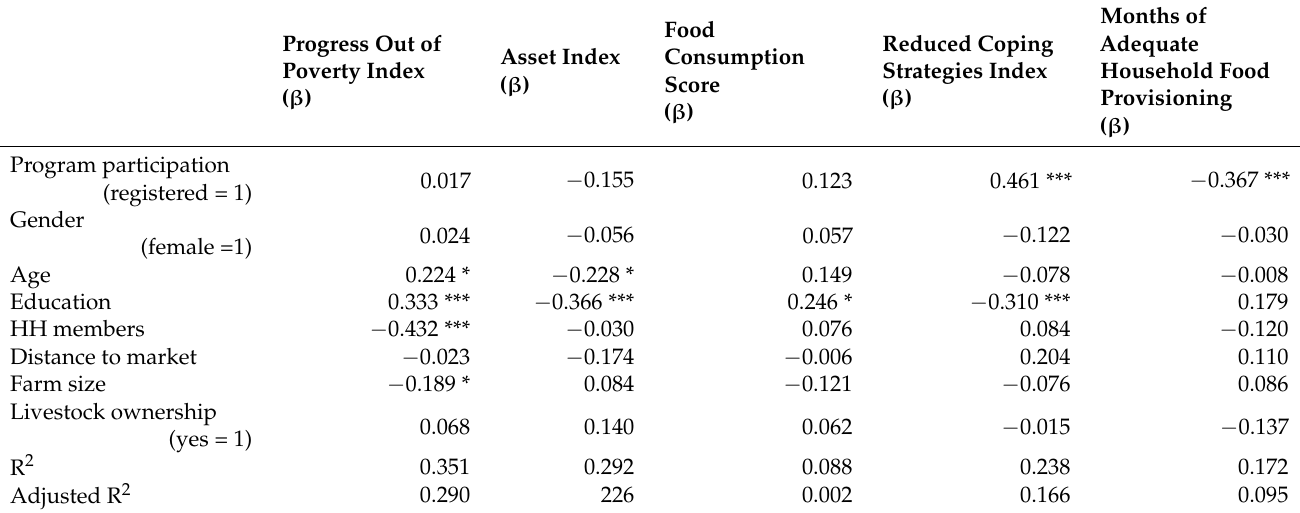
Table A3. Results of estimation of MI program participation as a determinant of poverty in Kasulu.